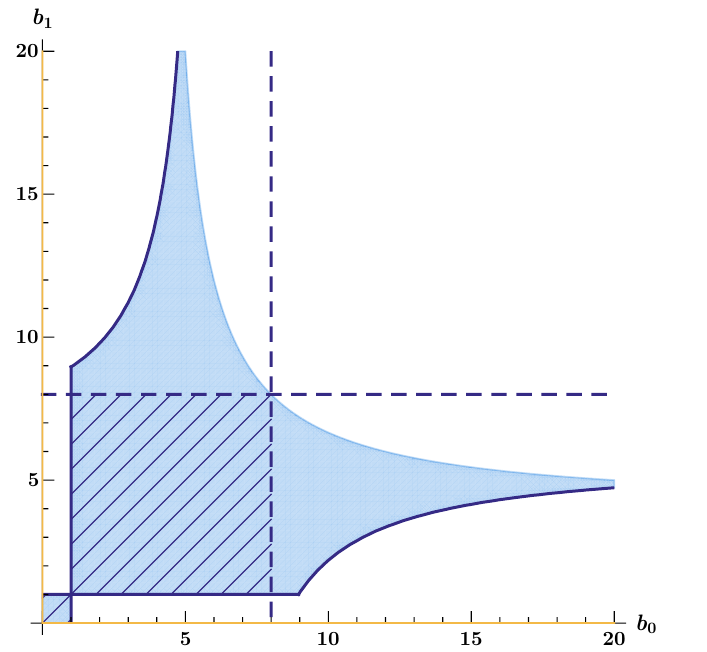
Figure 1 . Plot of the ( b 0 ; b 1 )-plane for an SU(2) model with T = 1, even string charge lattice, and positivity cone b 0 ; b 1 (cid:21) 0. Choices of b = ( b 0 ; b 1 ) within the positivity cone (bounded by the yellow curves) for which the AC equations have non-negative solutions with only generic matter are shaded in solid blue. The solid curves denote g = 0 ( b 0 ; b 1 = 1) and the gravitational bound (2.9a) on generic matter, which becomes a bound on b 0 ; b 1 using eq. (3.26). The dashed curves are b 0 ; b 1 = 8. The solid and dashed curves bound the hashed region where g (cid:21) 0 (a constraint necessary to have small b constraint). The hashed region lies entirely within the solid shaded region, showing